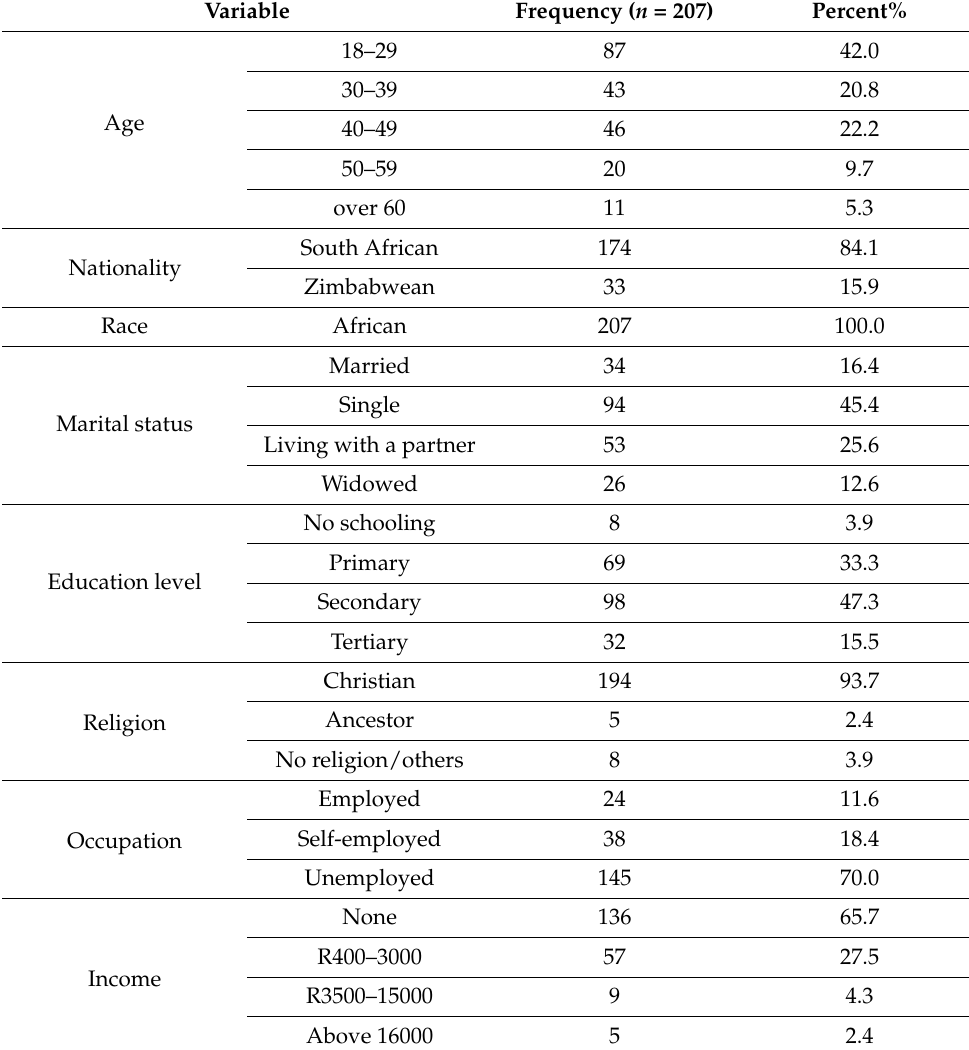
Table 1. Demographic profile of the